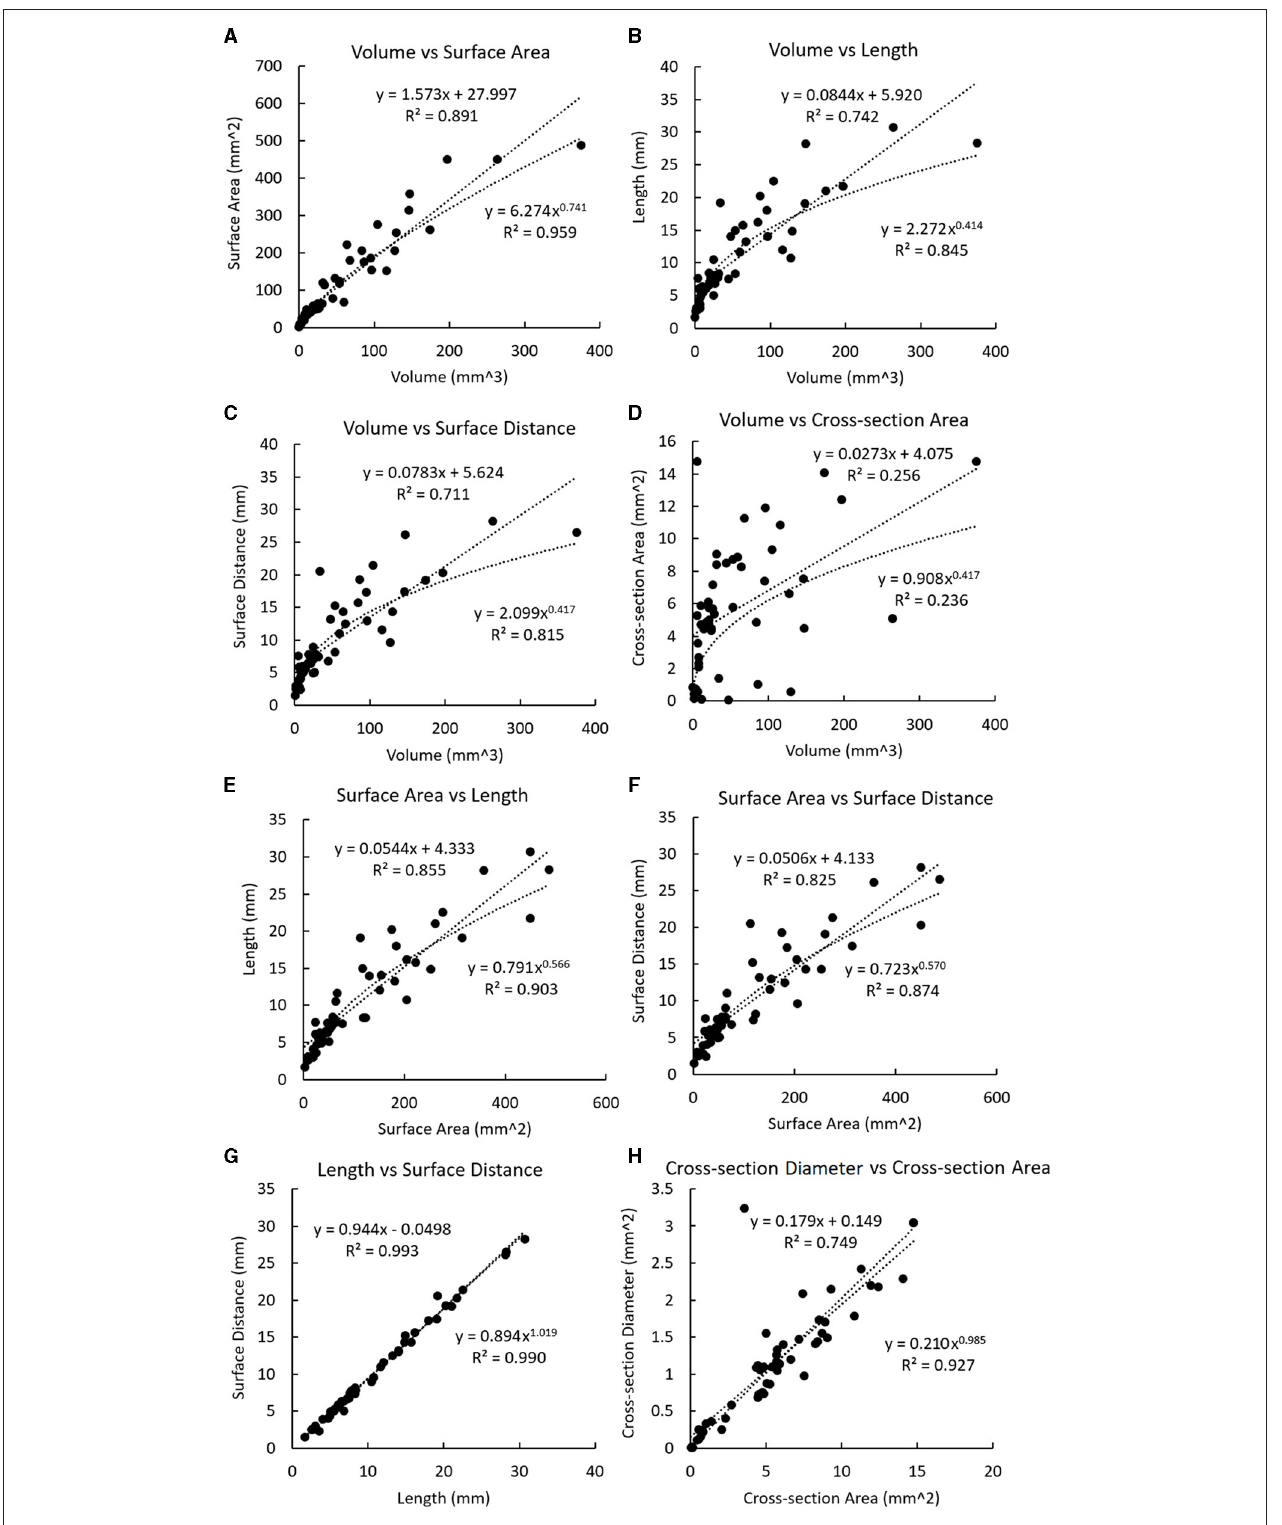
FIGURE 4 | Linear and non-linear regression fittings on the geometric parameters of plaques. The regression line and curve are shown in dotted lines. (A) The volume and the surface area. (B) Volume and length. (C) Volume and surface distance. (D) Volume and the cross-section area. (E) The surface area and length. (F) The surface area and surface distance. (G) Length and surface distance. (H) Cross-section diameter and the cross-section area.